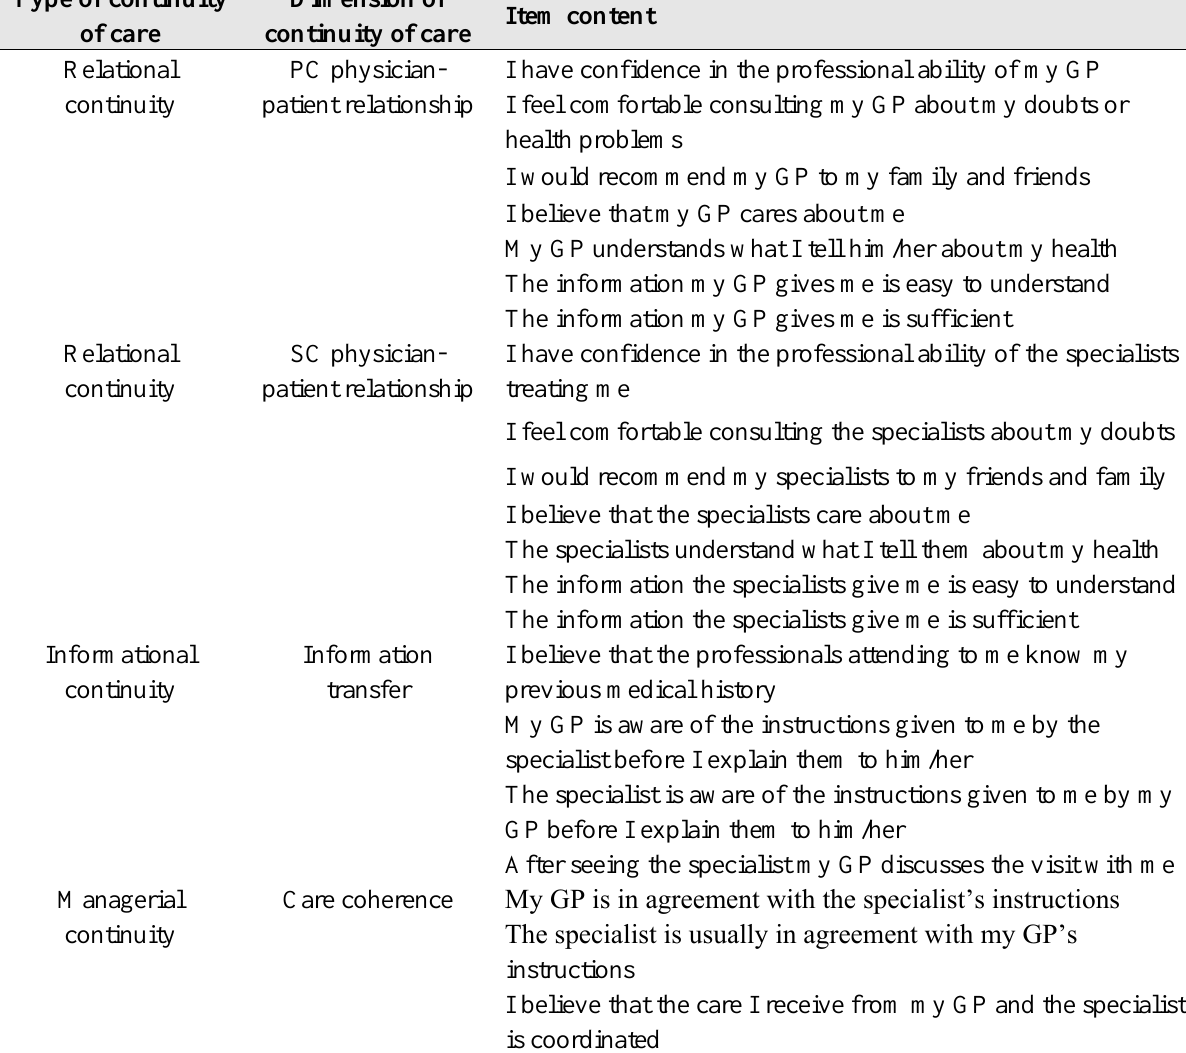
Table A1. Items that constitute each Likert